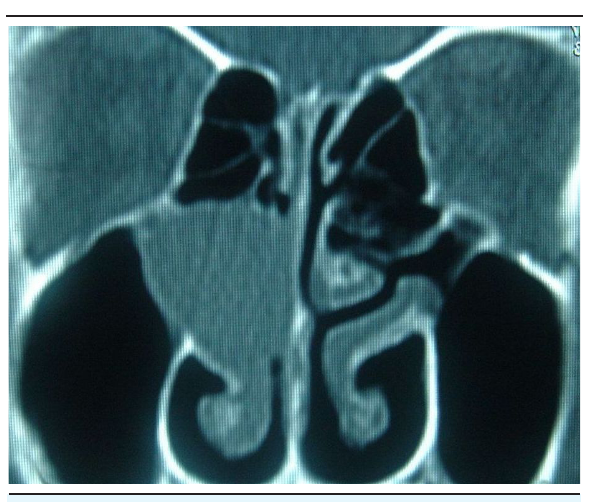
figure 1. nasal leiomyoma : ct scan showing homogeous opacity in right nasal cavity.